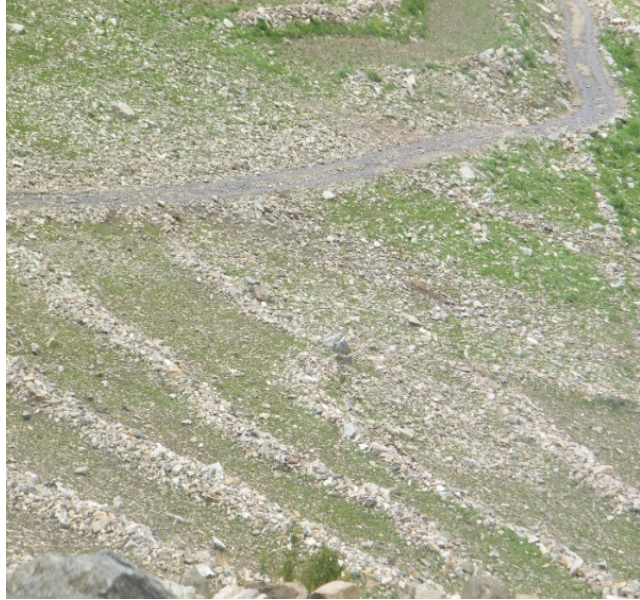
Figure 4. Agriculture abandoned land in Burhrawai valley.